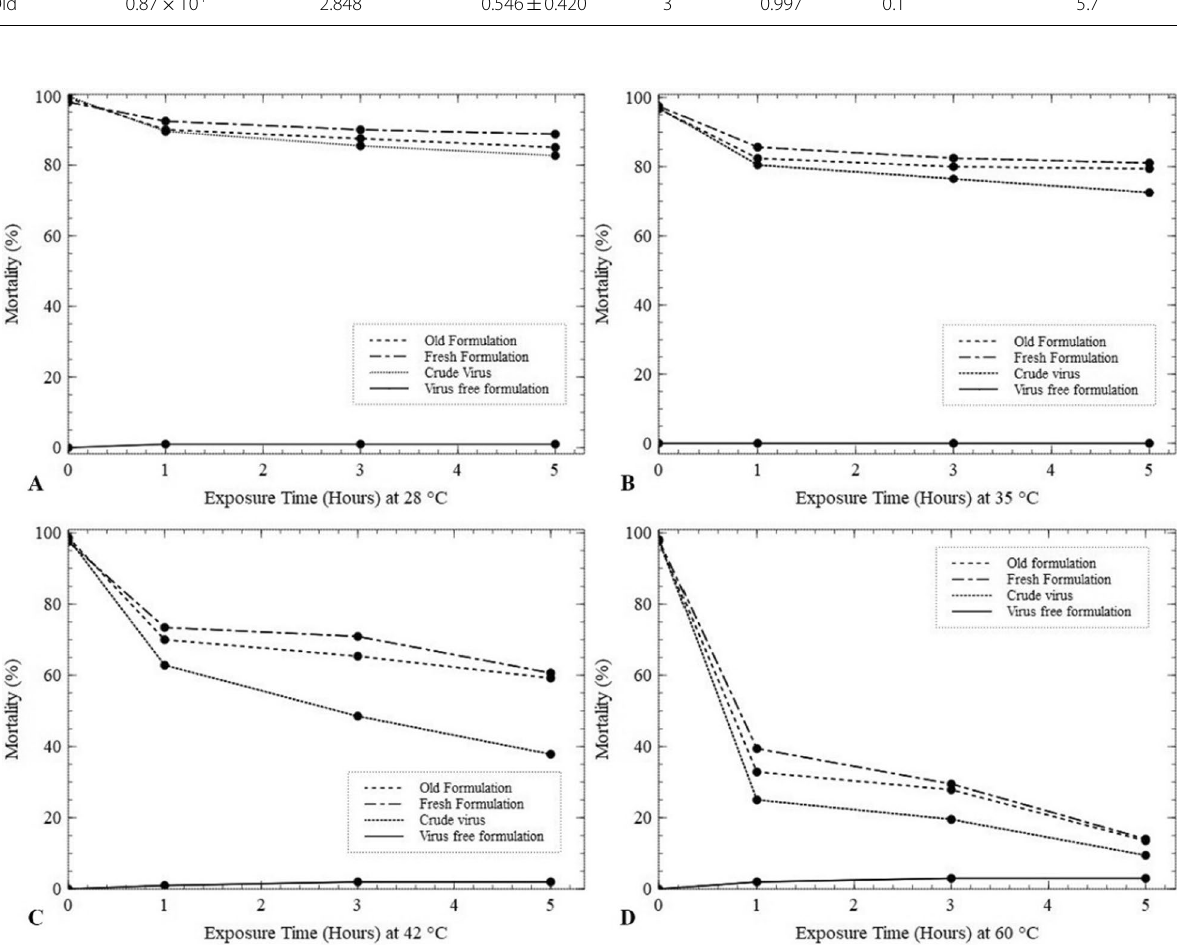
Fig. 2 Mortality rates after temperature application of crude virus, fresh, old formulations, and virus-free formulation against third instar Hyphantria cunea . A exposure to 28 °C; B exposure to 35 °C; C exposure to 42 °C; D exposure to 60